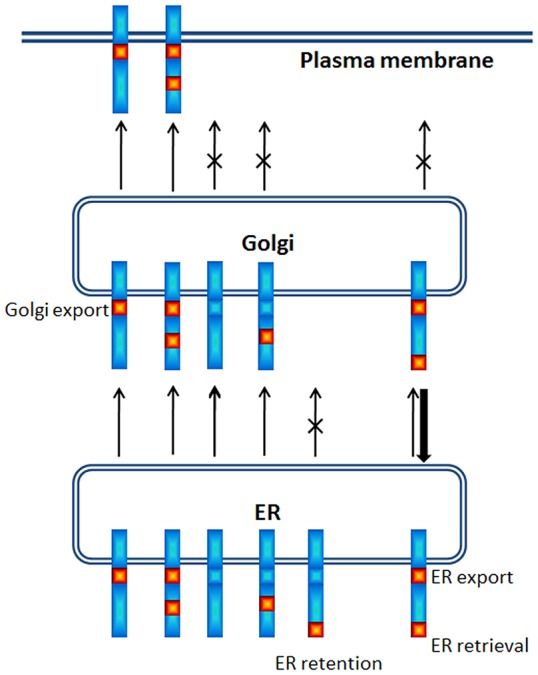
Summary of position-dependent effects of the PBM on p14 trafficking.Trafficking of p14 constructs (blue) containing the PBM (red) in membrane-proximal, C-terminal or internal locations in the p14 cytoplasmic endodomain, as described in the text, is depicted. Arrows indicate trafficking of the various constructs between the ER, Golgi and plasma membrane, with an X indicating inhibition and thin and thick arrows indicating relative strength of directional trafficking. The positional-dependent functions of the PBM at specific locations in Golgi export, ER retention, ER export or ER retrieval are indicated.